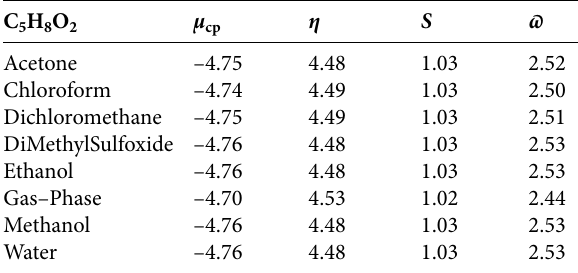
Table 7: PCM-CAM-B3LYP/6-311+G(d) results for the electronic chemical potential ( µ cp ), the chemical hardness ( η ), softness (S), and the global electrophilicity index ( ϖ ) (in eV) of compound C 5 H 8 O 2 in a solvent medium.